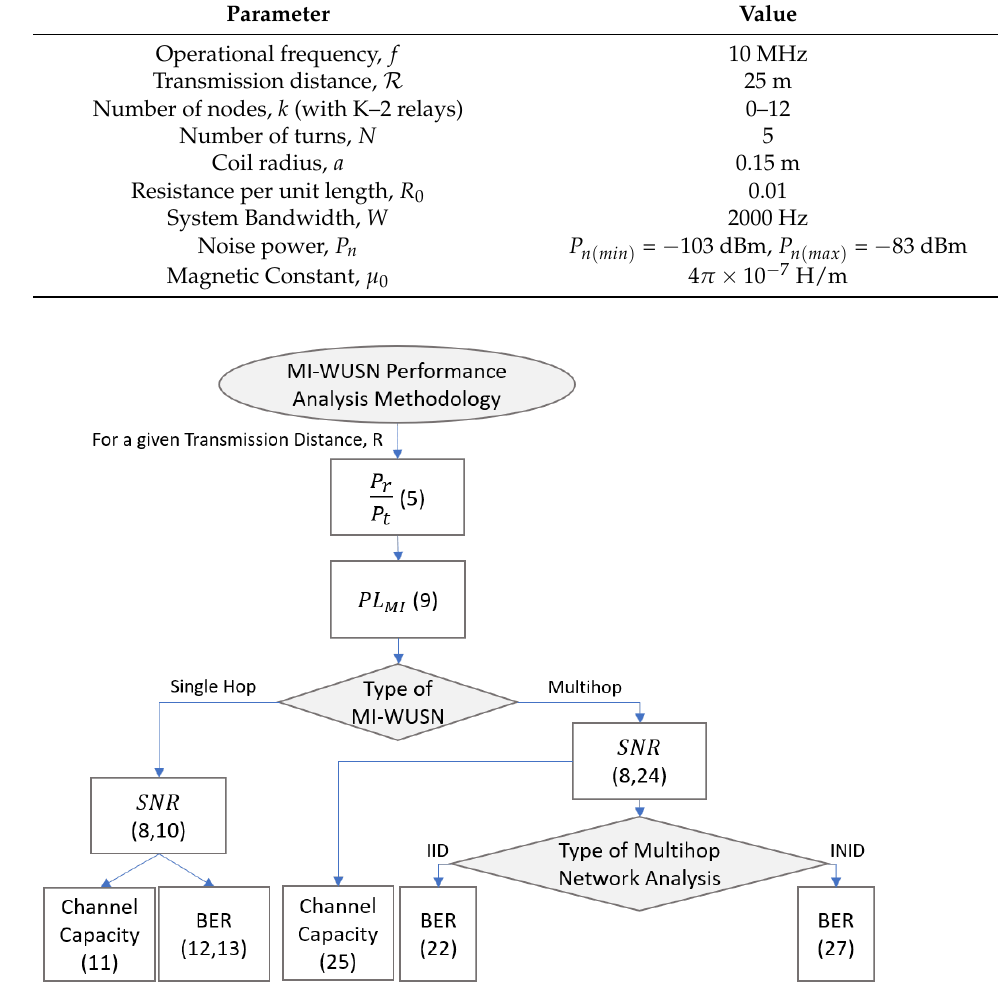
Table 2. Parameters used for evaluating the wireless underground MI sensor network system’s performance.